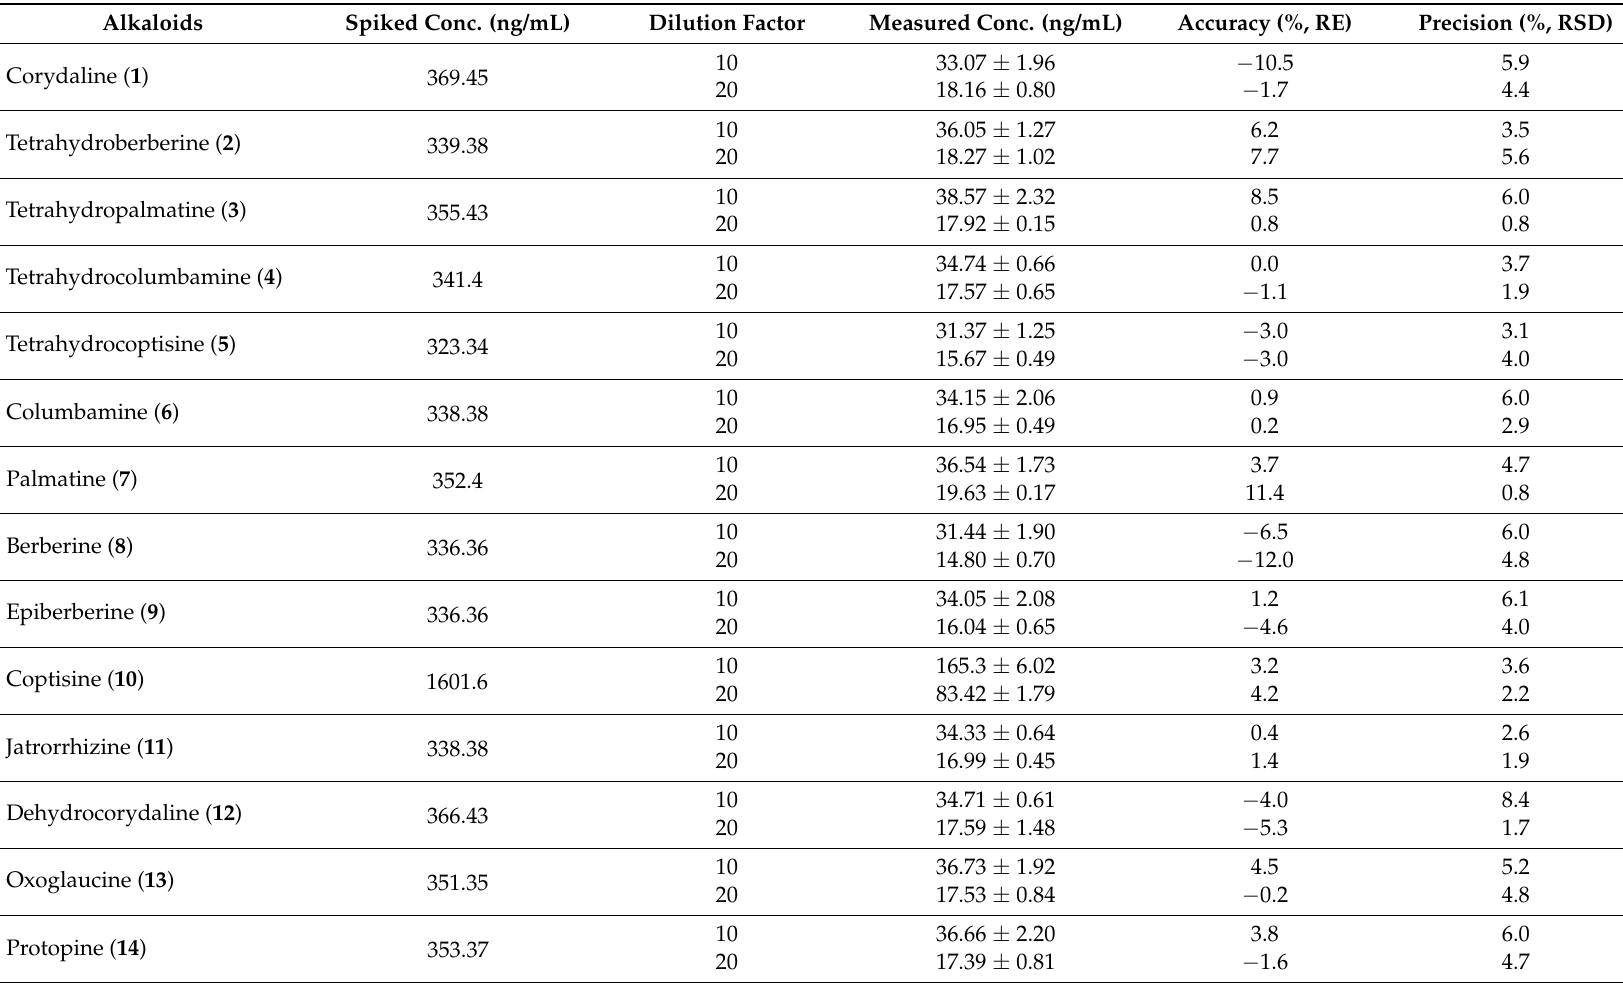
Table 6. The dilution integrity of the fourteen alkaloids in ICR mice plasma (mean ± SD, n =